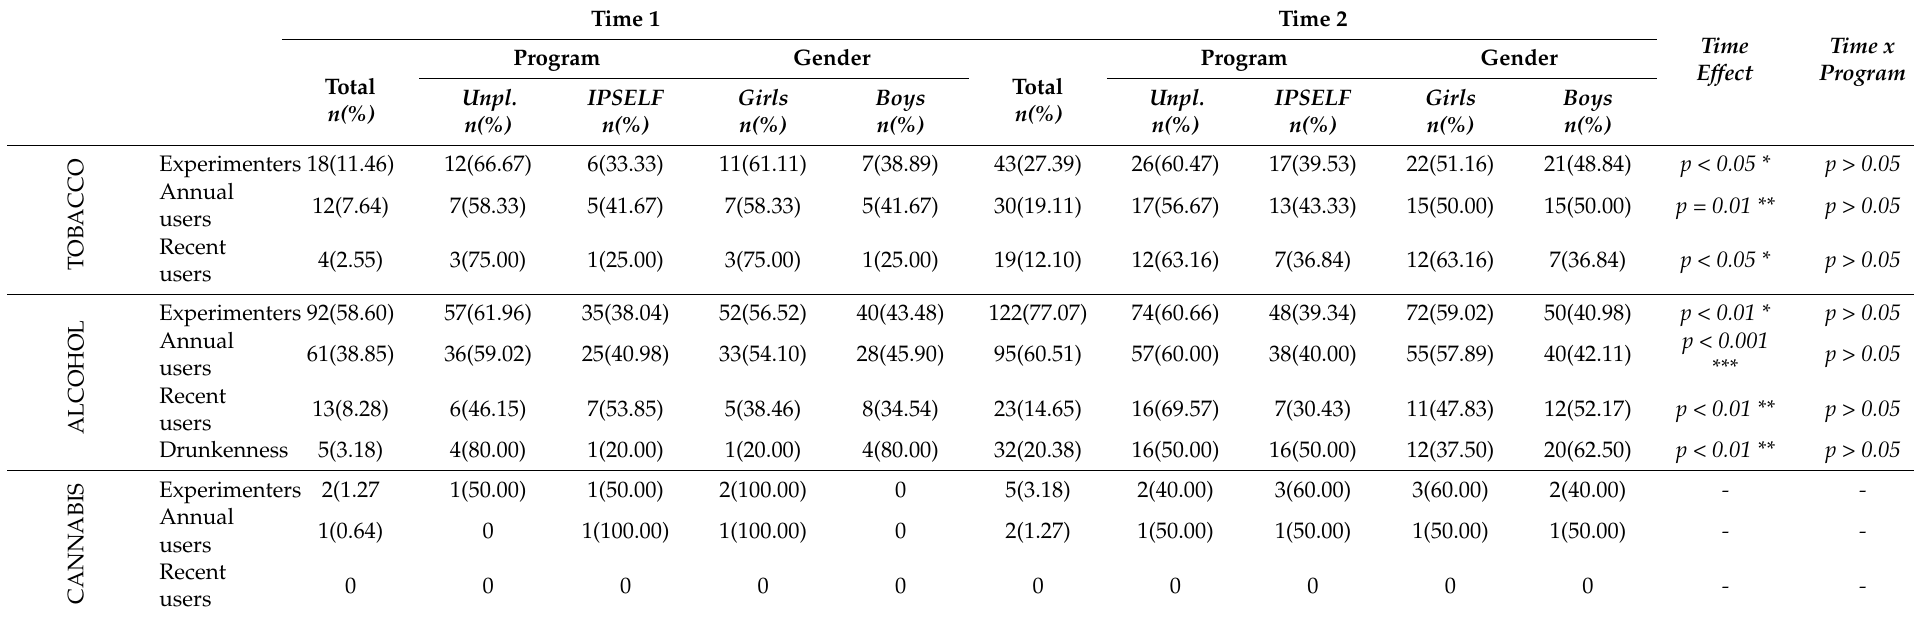
Table 3. Number of experimenters, annual users and recent users of tobacco, alcohol and cannabis by program and